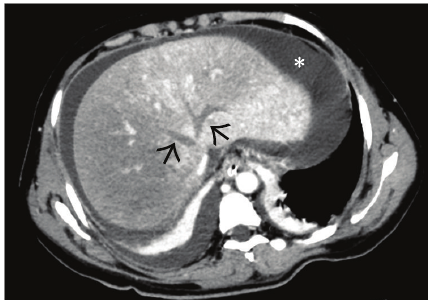
Figure 23: Thrombosed middle and left hepatic veins appearing as hypodense nonenhancing structures (arrows) on a background of heterogeneous liver parenchyma and ascites